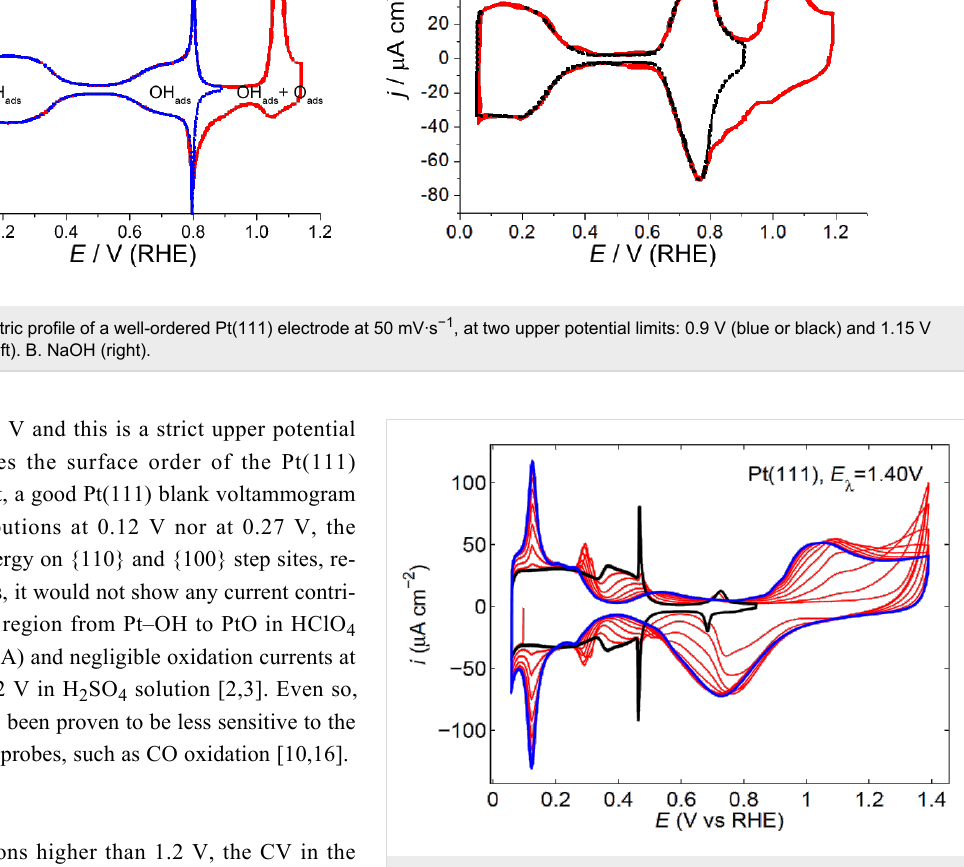
Figure 2: Evolution of the voltammetric profile of a Pt(111) electrode in 0.5 M H 2 SO 4 as the electrode is cycled at 50 mV·s − 1 between 0.06 and 1.4 V vs RHE. The black line shows the initial stable profile up to 0.85 V and the blue line the profile attained after 12 cycles (partially represented in